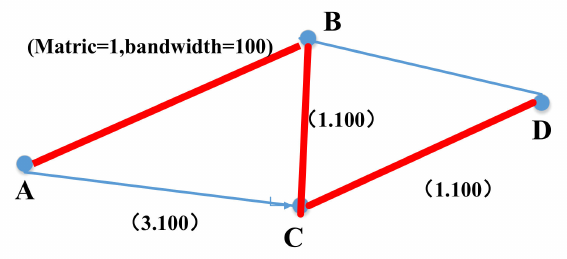
Figure 2. Dijkstra’s algorithm